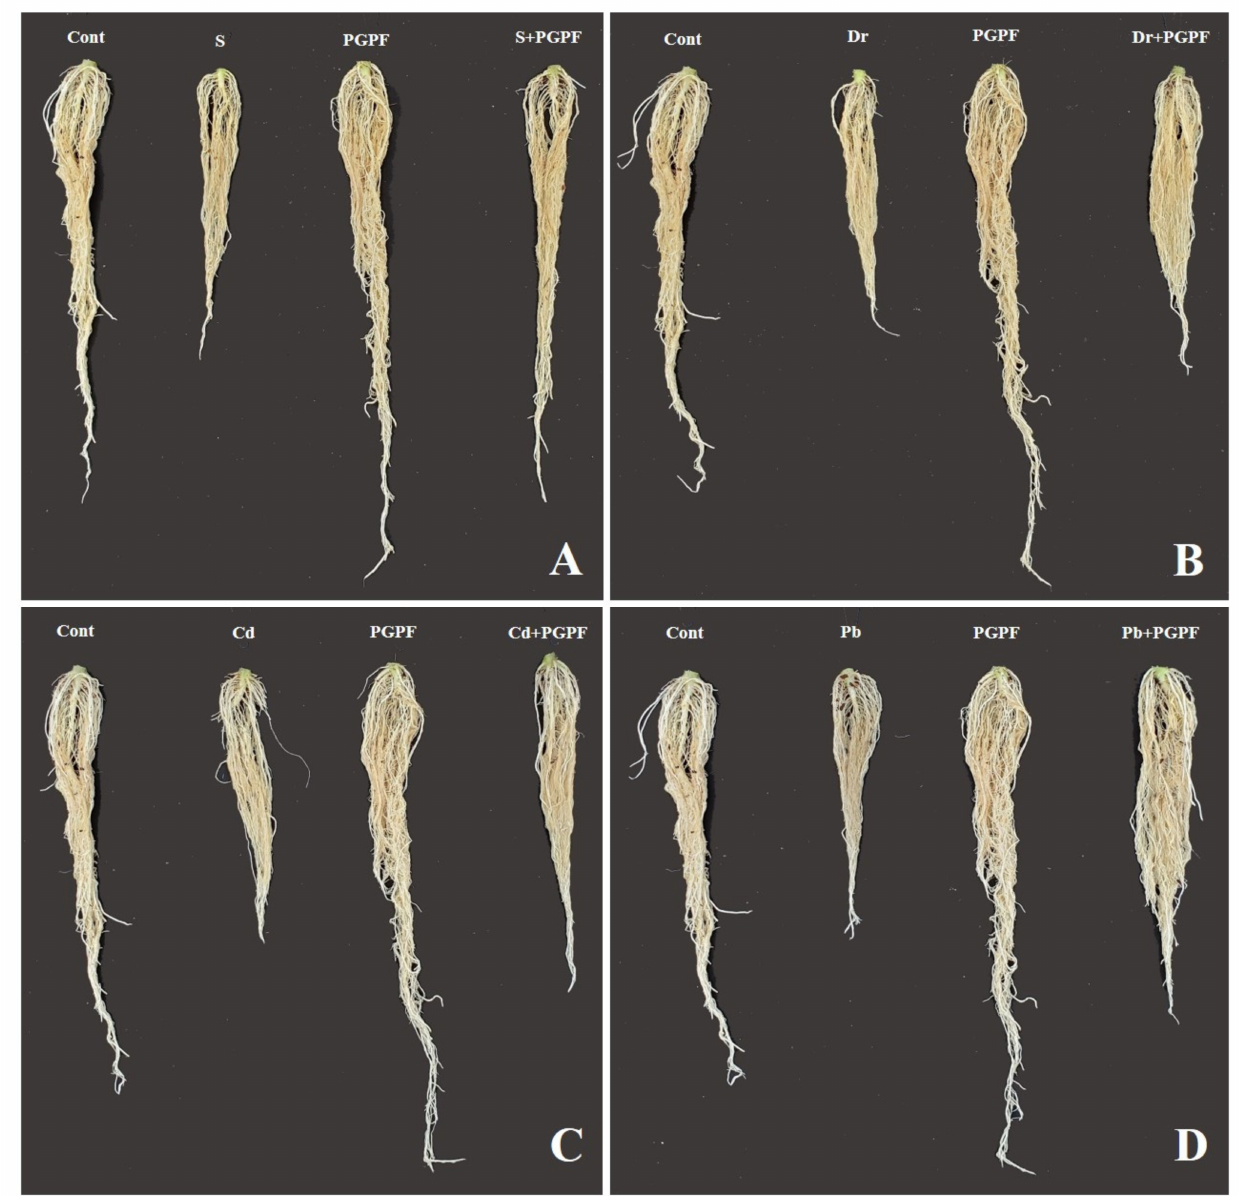
Figure 3. Effects of PGPF inoculation on tomato plant root under normal and stress conditions after 10 days of treatment ( A – D ). Treatments: Cont (control), PGPF ( Cunninghamella bertholletiae